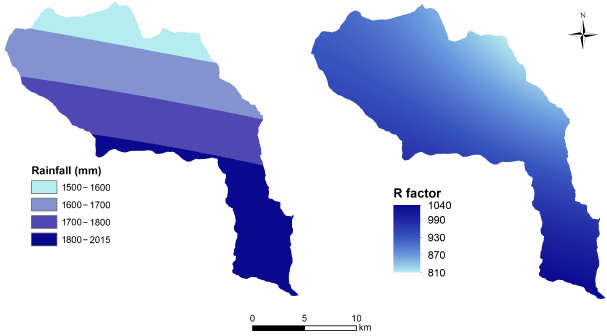
Figure 3. Map of mean annual rainfall (left) and rainfall erosivity (right) distribution of the study